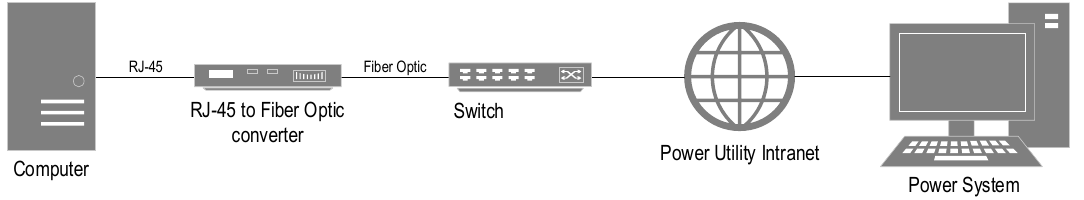
Figure 9. Scheme for communication.